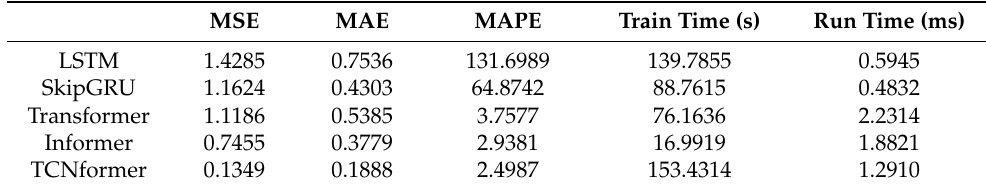
Table 5. The 24-h scenario prediction